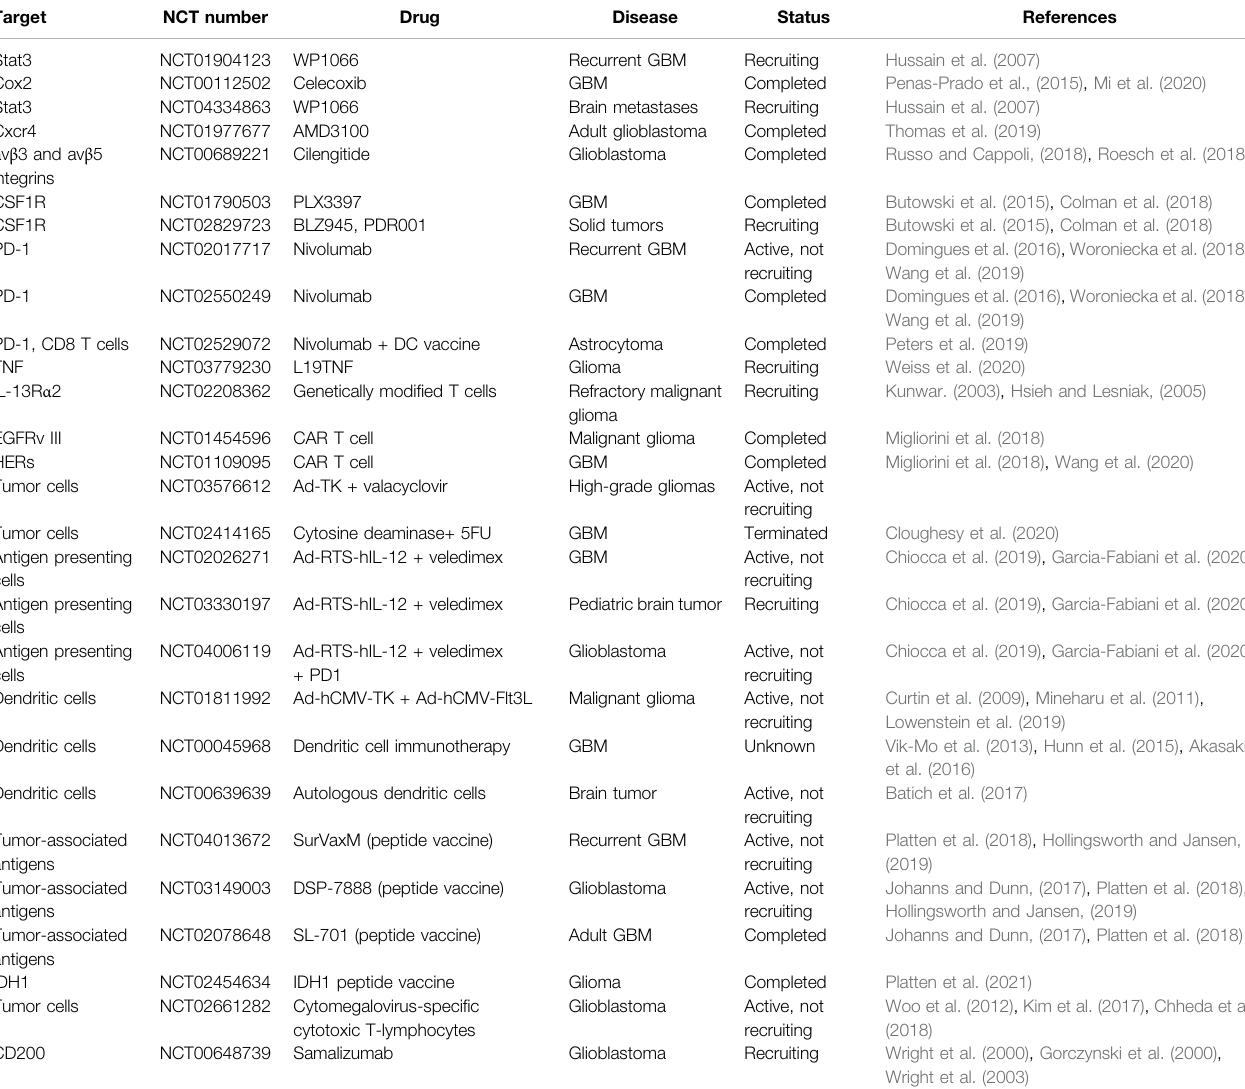
TABLE 1 | Selected ongoing clinical trials of immunotherapy in